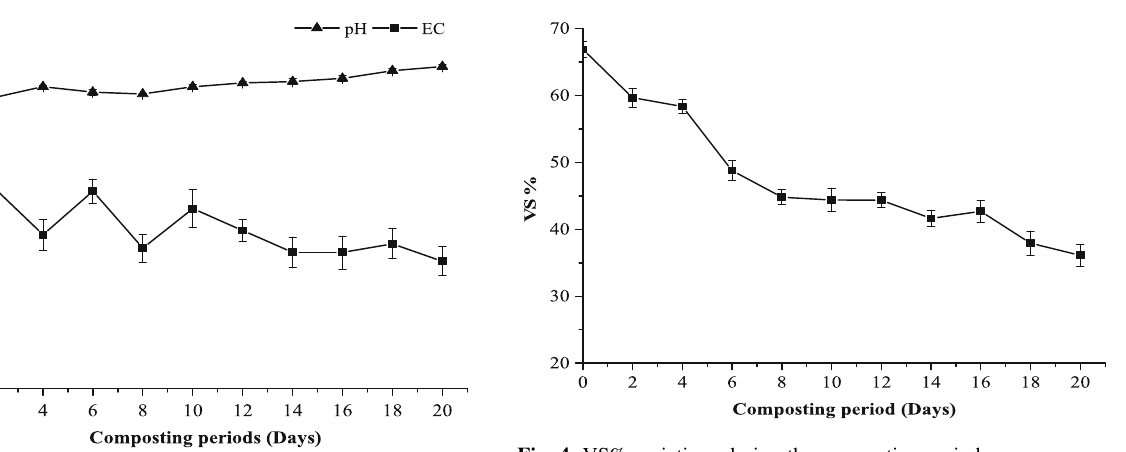
Fig. 3 pH and EC variations during the 20-day composting period